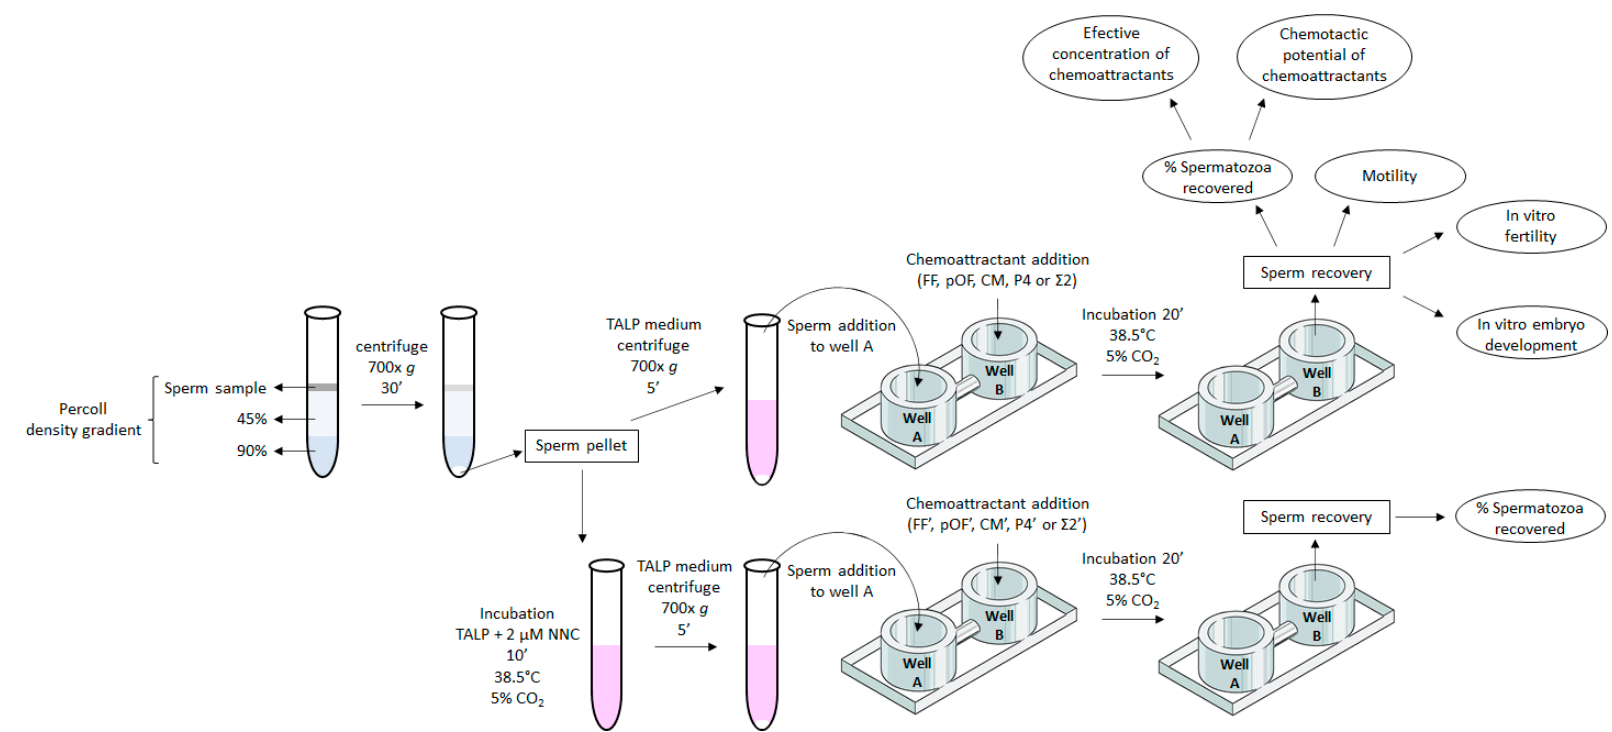
Figure 1. Diagram of the experimental design. Boar ejaculated spermatozoa were separated from seminal plasma by centrifugation on a discontinuous density gradient (Percoll). The pellet was resuspended in TALP medium supplemented or not with 2 µM of the CatSper inhibitor NNC 55-0396 (NNC). Spermatozoa resuspended in TALP + NNC were incubated for 10 min (38.5 °C, 5% CO 2 ). Chemotactic chamber was loaded with 500 µL TALP medium per well. Chemoattractants were added to well B of the chemotactic chamber (in different concentrations depending on the experiment). Sperm samples in fresh TALP were centrifuged 700× g , 5 min and added to the well A of the chamber. The chemotactic system was incubated for 20 min (38.5 °C, 5% CO 2 ). Spermatozoa recovered in well B were analyzed: % of spermatozoa recovered, motility, in vitro fertility, and in vitro development of blastocyst [just for spermatozoa selected by follicular fluid (FF)]. With the % of spermatozoa recovered in well B, it was also determined the effective concentration of chemoattractants (lowest concentration of chemoattractant that attracted the highest proportion of spermatozoa), and the chemotactic potential of chemoattractants [comparison of the most effective concentra- tion of chemoattractants through the % of spermatozoa recovered in well B attracted by each chemoattractant and a combination of them ( Σ )].